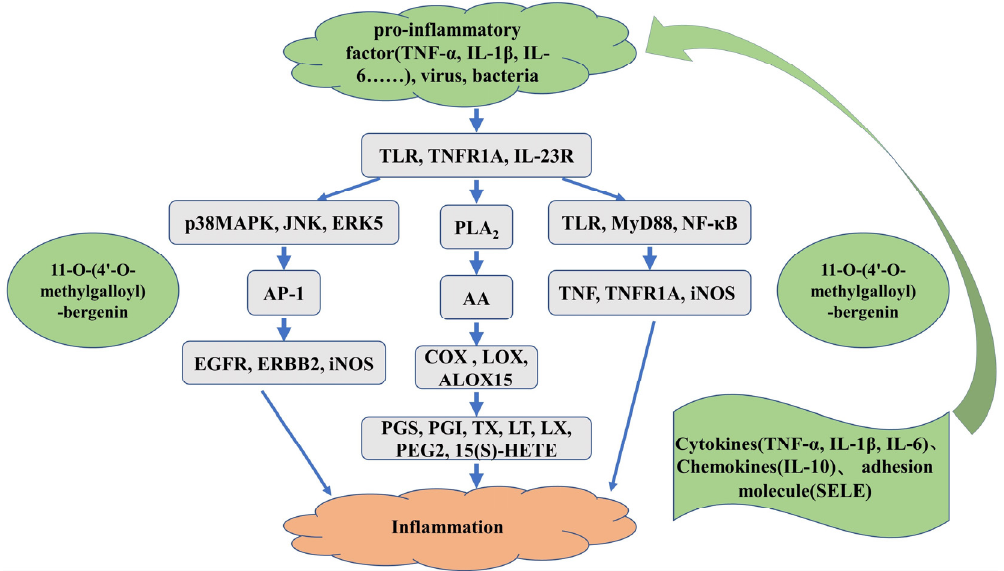
Figure 4. The schematic diagram of the involved inflammatory-related mechanisms.